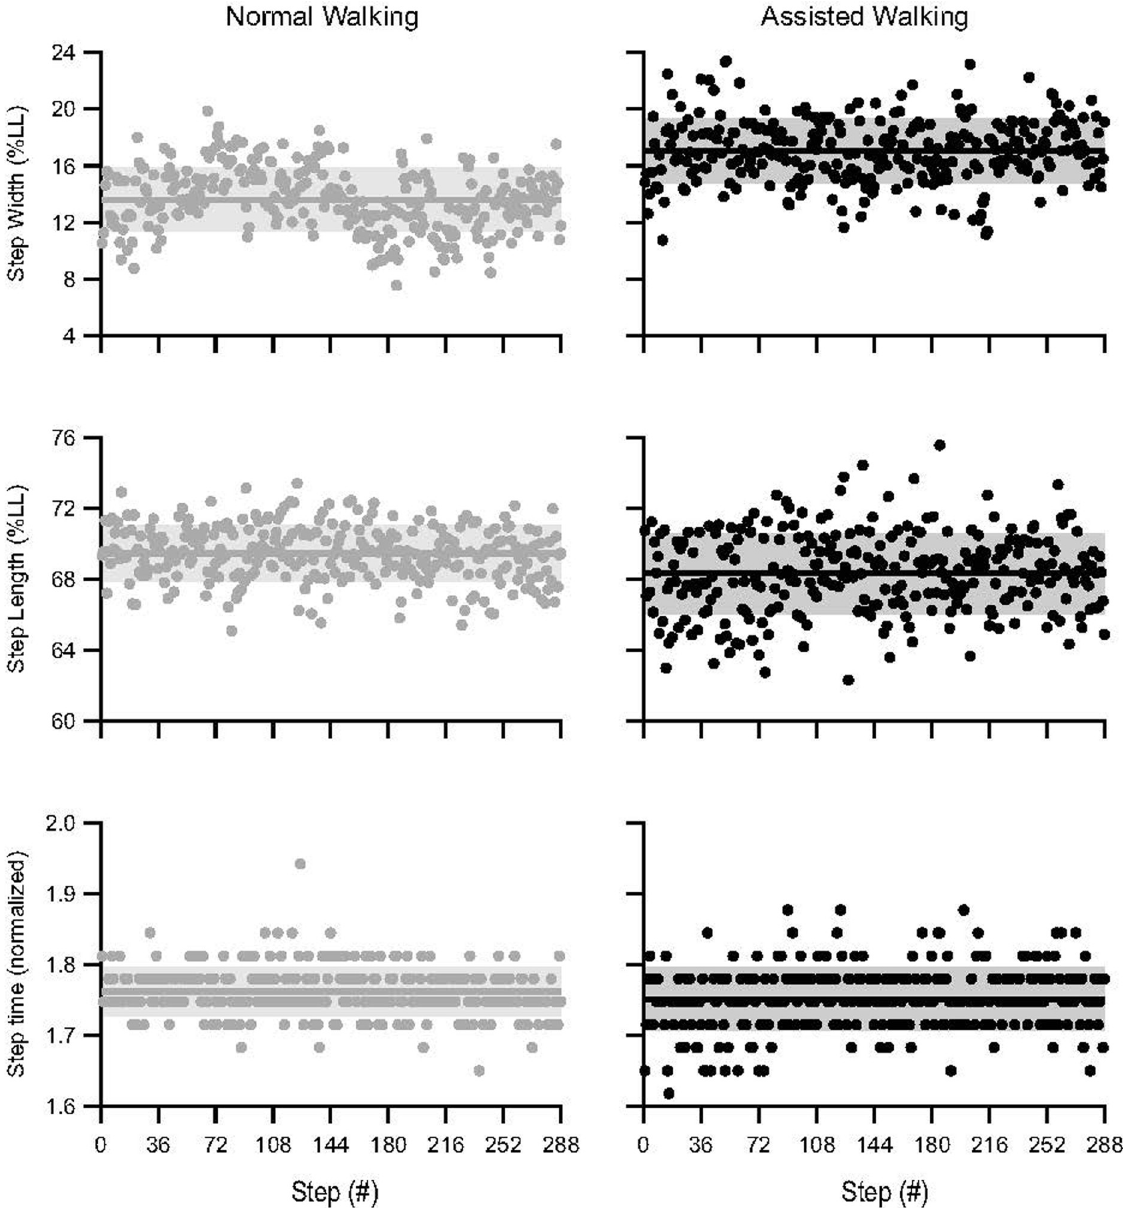
Fig 2. Time series data ( n = 1). Solid circles represent values for each step over a series of 288 consecutive steps for one subject. Average (solid line) ± 1 SD (shaded region) are shown for each stepping parameter during normal and assisted walking conditions. When compared to normal walking, the subject increased their average step width by 0.032 m (normalized: 3.45% LL) during assisted walking, but step width variability remained relatively unchanged (2.27% LL vs 2.26% LL). Additionally, this subject slightly decreased their average step length by 0.011 m (normalized: 1.13% LL) and exhibited a 0.006 m (normalized: 0.69% LL) increase in step length variability. Lastly, the subject did not alter their average step time (54 ms vs 54 ms), but their step time variability slightly increased by 3.2 ms (normalized: 0.01). Note that all subjects responded in a slightly different way (see Fig 3 for individual